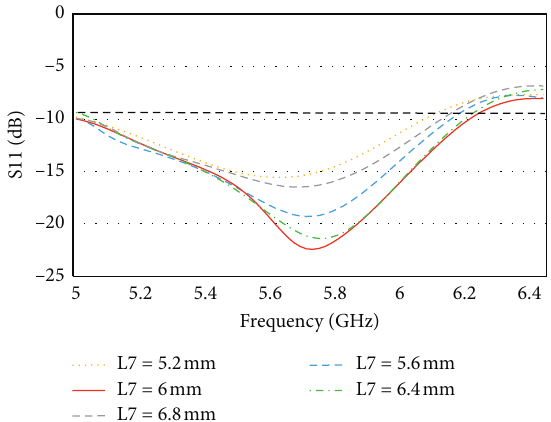
Figure 6: Variation of S11 (dB) for various L